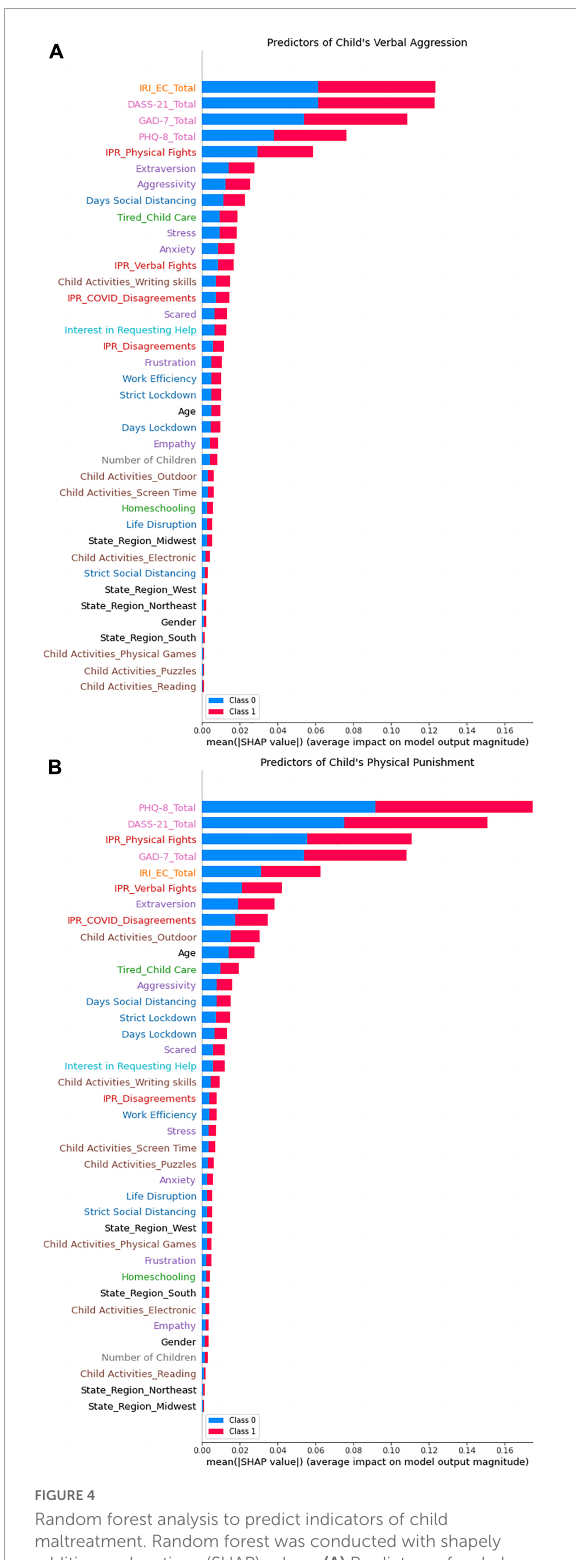
FIGURE4 Random forest analysis to predict indicators of child maltreatment. Random forest was conducted with shapely additive explanations (SHAP) values. (A) Predictors of verbal aggression toward children. (B) Predictors of physical punishment toward